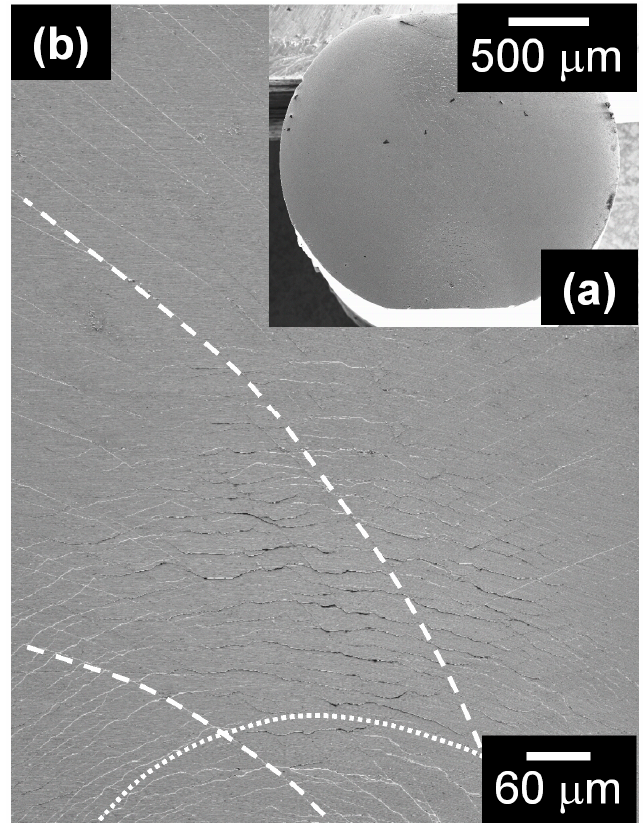
Figure 6. Cross-section of the metallic glass cold-rolled to a diameter reduction of 10%, revealing the formation of different types of shear